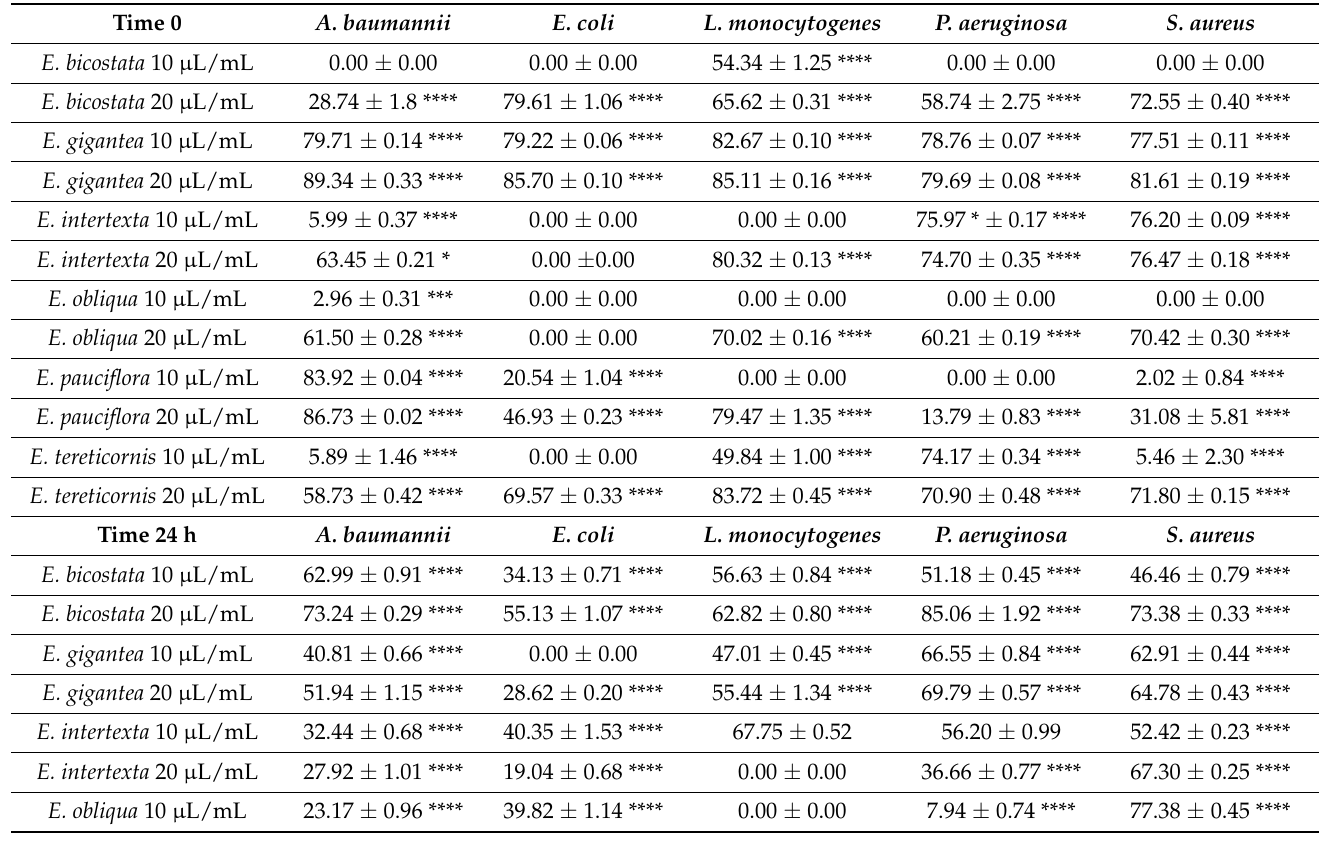
Figure 1. Typical bacterial biofilm after crystal violet staining and before dissolution with acetic acid 20%. Ab: A. baumannii; Ec: E. coli; Lm: L. monocytogenes; Pa: P. aeruginosa; Sa: S. aureus. Table 7. Percent inhibition of two doses of the EOs on biofilm metabolic activity of A. baumannii , E. coli , L. monocytogenes, P. aeruginosa , and S. aureus at 0 and 24 h.